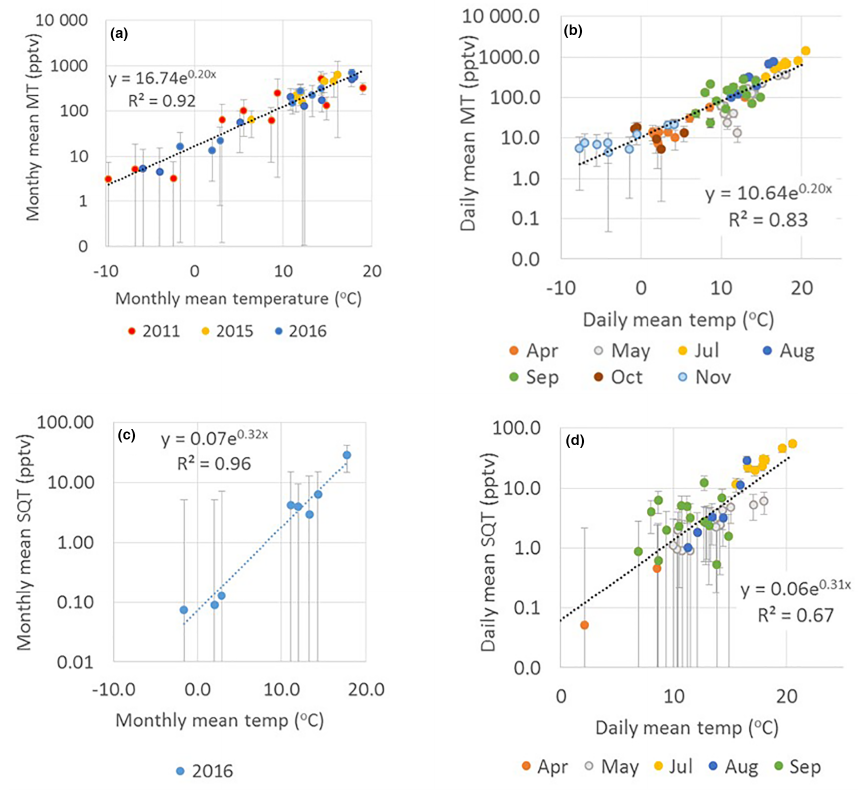
Figure 5. Exponential correlation of temperature with (a) monthly mean MT concentrations in 2011, 2015 and 2016; (b) daily mean MT concentrations in 2016; (c) monthly and (d) daily mean SQT concentrations in April–November 2016 measured at SMEAR II. Error bars show the uncertainty of the mean concentrations calculated from the uncertainty of the measurements. Note that the y axes are in a logarithmic